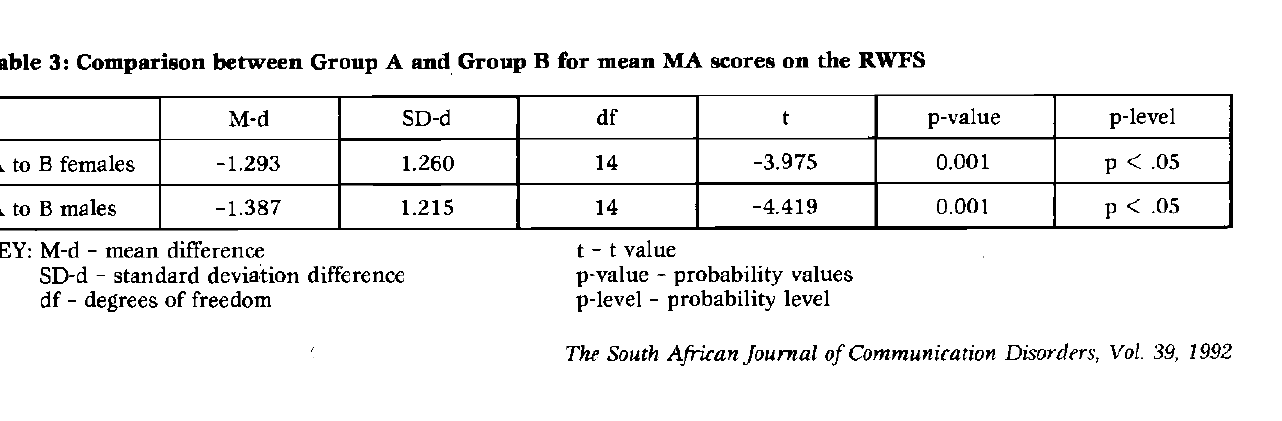
Table 3: Comparison between Group A and Group Β for mean MA scores on the